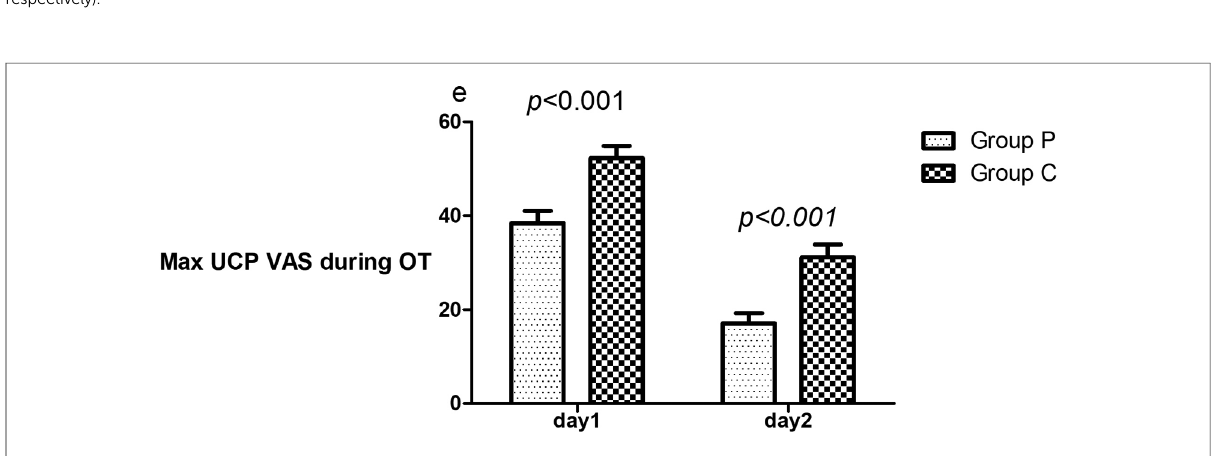
FIGURE 2 Comparison of maximum UCP VAS during oxytocin on days 1 and 2. The mean scores of patients in Groups P and C who underwent GIK and NS. VAS, visual analog scale (0 – 100, where 0 and 100 denote no and maximum pain, respectively); UCP, uterine cramping pain; OT, oxytocin; Max, maximum; GIK, glucose – insulin – potassium; VAS, visual analog